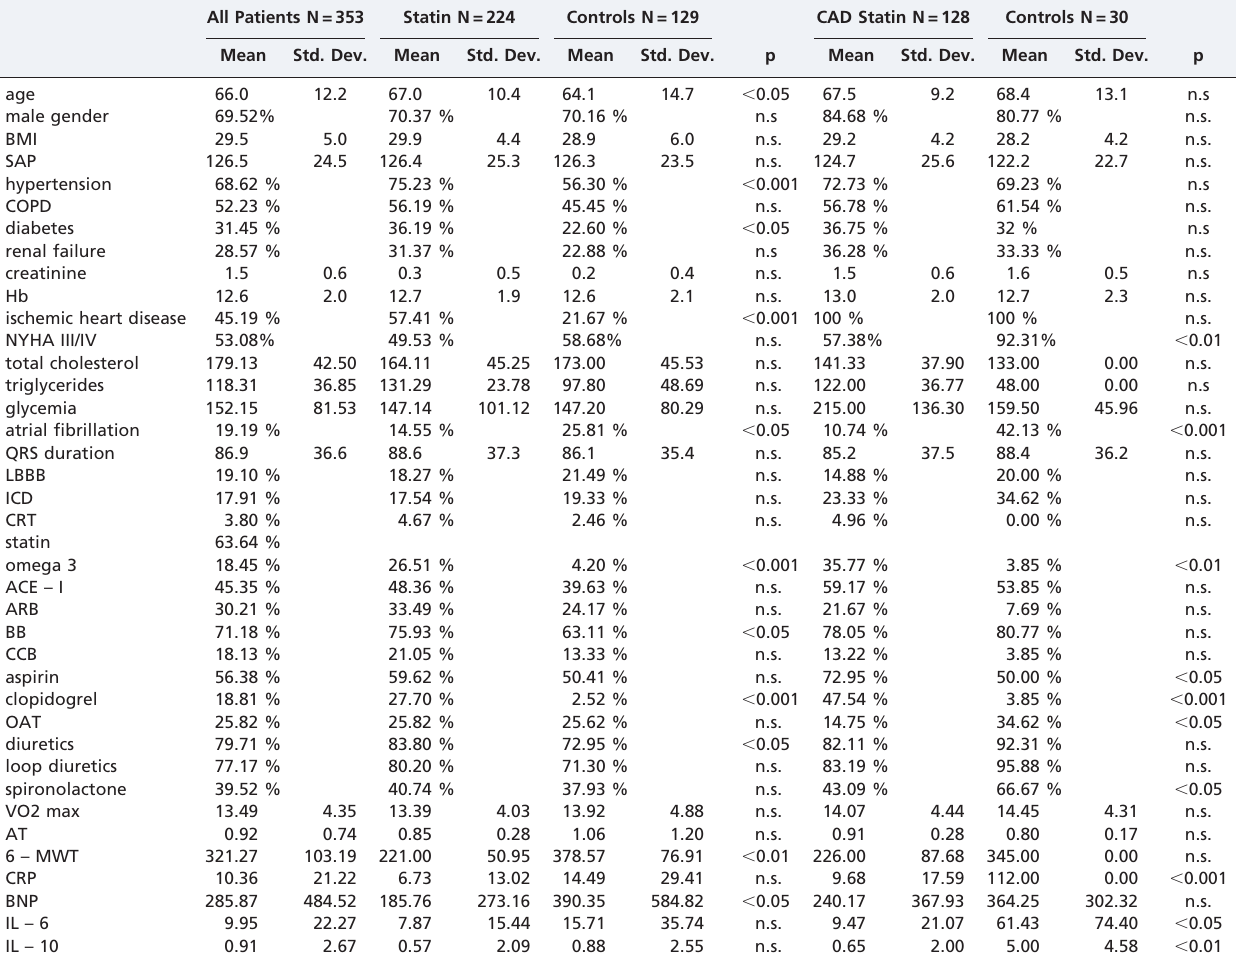
Table I - Clinical characteristics. All Patients